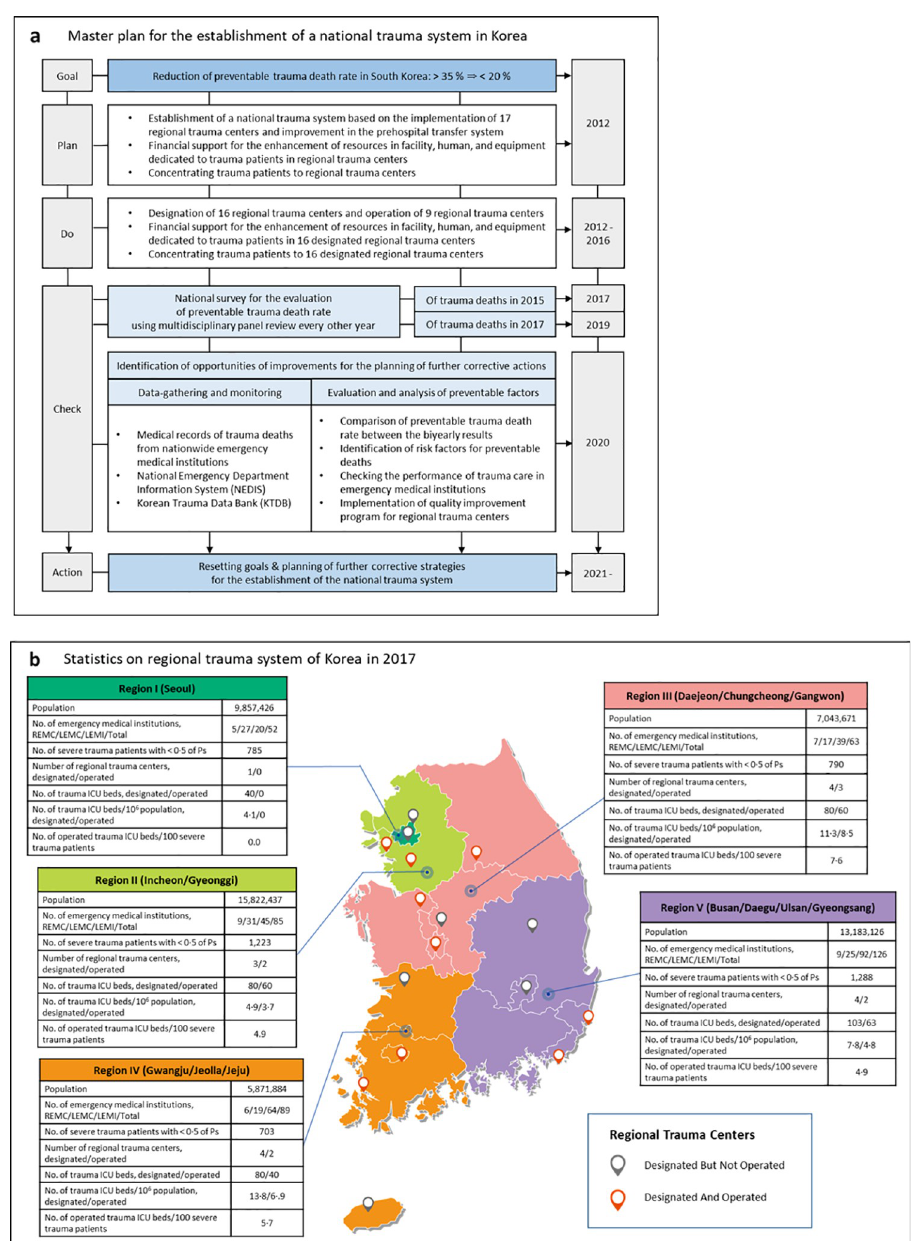
Fig 1. Master plan for the establishment of a national trauma system in South Korea. (a) shows the master plan for the establishment of a national trauma system in South Korea. The South Korean government and medical society created the master plan in 2012. It was based on the implementation of regional trauma centers and improvement in the prehospital transfer system for transferring the majority of severe trauma patients to trauma centers. (b) shows that 16 regional trauma centers were designated, and nine regional trauma centers were officially operational by 2017 after a preparation period of 1–3 years from 2012 to 2016. It also shows the number of trauma intensive care unit beds per population and severe trauma patients in 2017 according to the five regions (divided in consideration of the population and the administrative district classification in South Korea). No, number; REMC, Regional Emergency Medical Center; LEMC, Local Emergency Medical Center; LEMI, Local Emergency Medical Institution; ICU, intensive care unit.